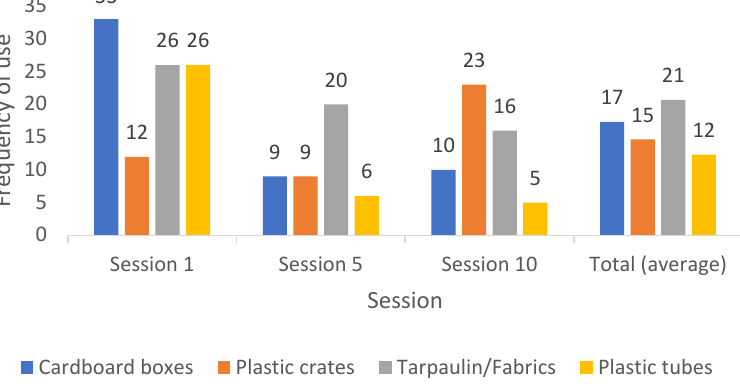
Figure 3. Frequency use of each material by session and average frequency in the total of the three sessions.